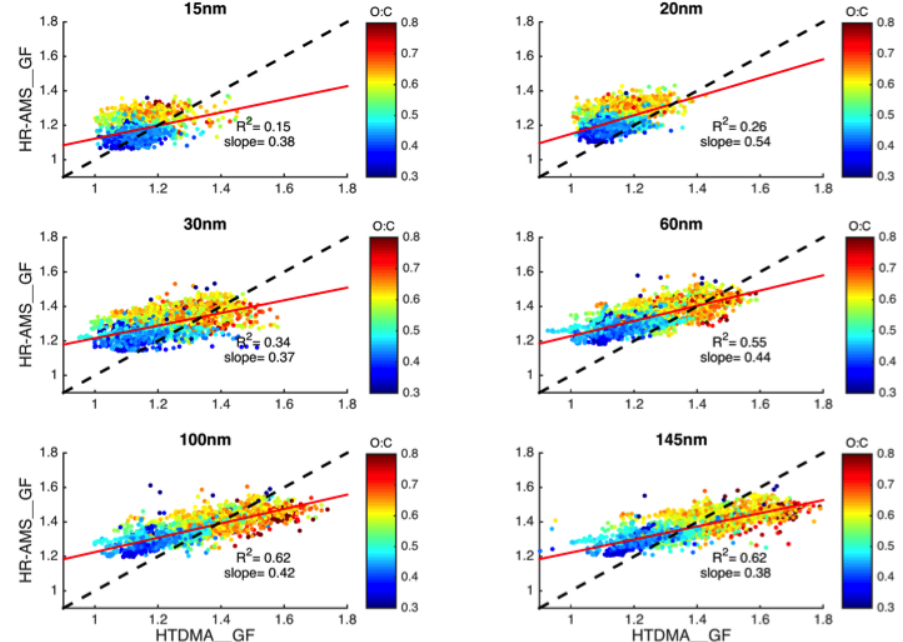
Figure 5. Comparison of HR-AMS-derived HGF with HTDMA-measured HGF of different-sized particles. The dashed lines indicate the 1 : 1 lines.